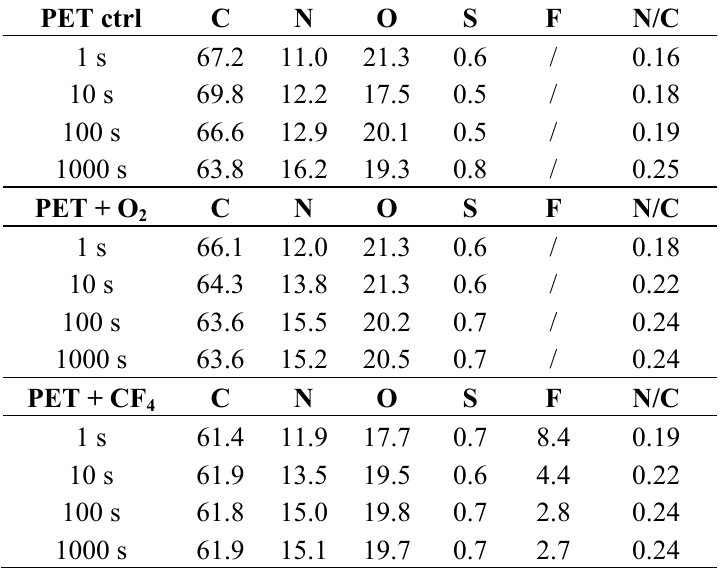
Table 2. Surface composition of the samples after incubation in albumin solution (in atomic